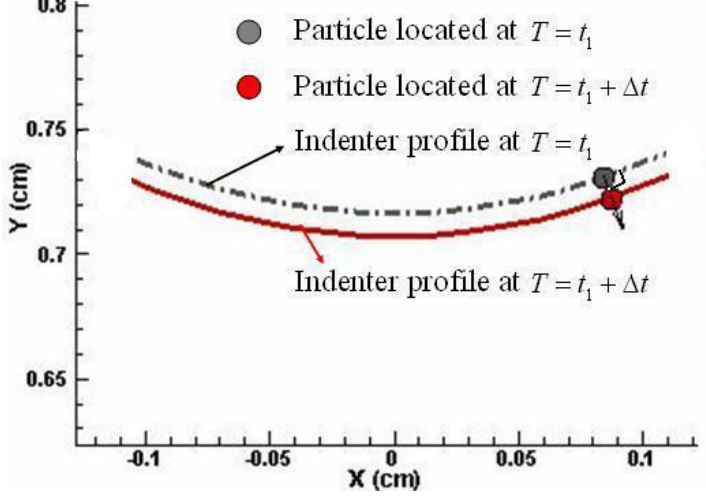
Figure 9. Implementation of a coupling between rigid impactor and polymeric